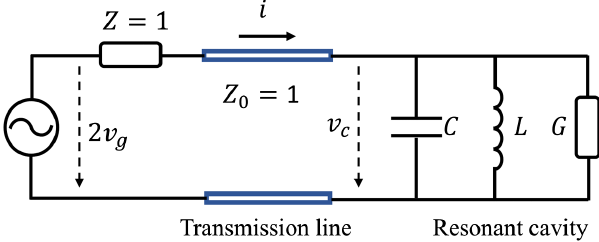
FIG. 18. Equivalent circuit of a storage cavity feed by a generator through a transmission line.